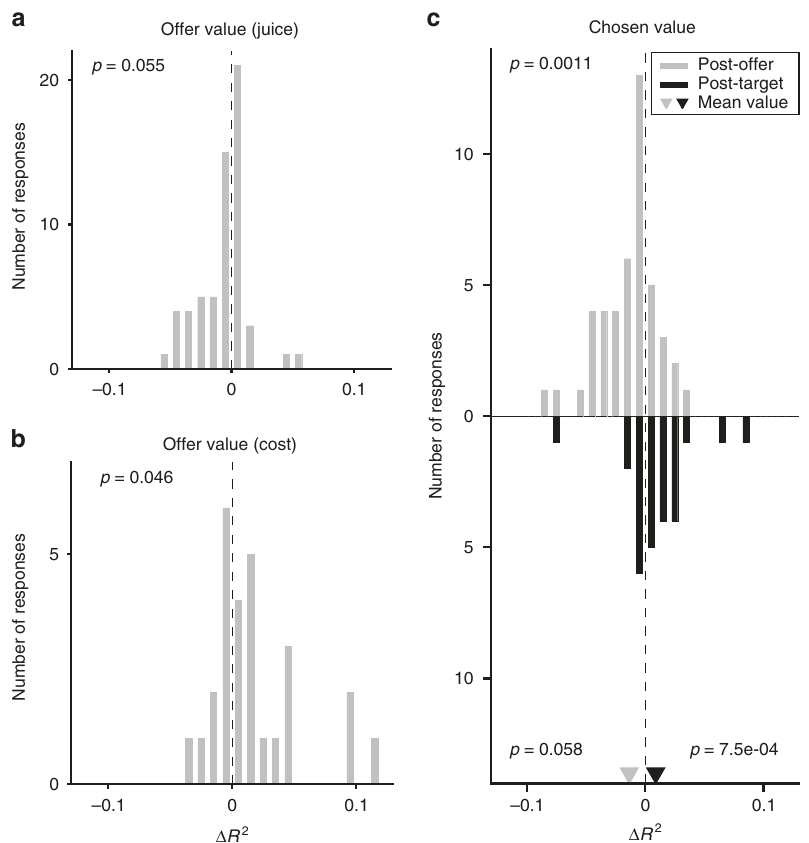
Fig. 7 Model comparisons. a Offer value (juice) responses ( N = 60). The x axis represents the difference Δ R 2 . Across the population, mean( Δ R 2 ) = − 0.0065 ( p = 0.055, Wilcoxon signed-rank test). b Offer value (cost) responses ( N = 27). The x axis represents the difference Δ R 2 . Across the population, mean( Δ R 2 ) = 0.017 ( p < 0.05, Wilcoxon signed-rank test). c Chosen value responses. The x axis represents the difference Δ R 2 . In this case, we examined separately early time windows (top, N = 45 responses) and late time windows (bottom, N = 25 responses). In early time windows, mean( Δ R 2 ) = − 0.013 ( p < 0.01, Wilcoxon signed-rank test). In late time windows, mean( Δ R 2 ) = 0.0089 ( p = 0.058, Wilcoxon signed-rank test). The difference between the two measures was statistically signi fi cant ( p < 0.001, Wilcoxon ranksum